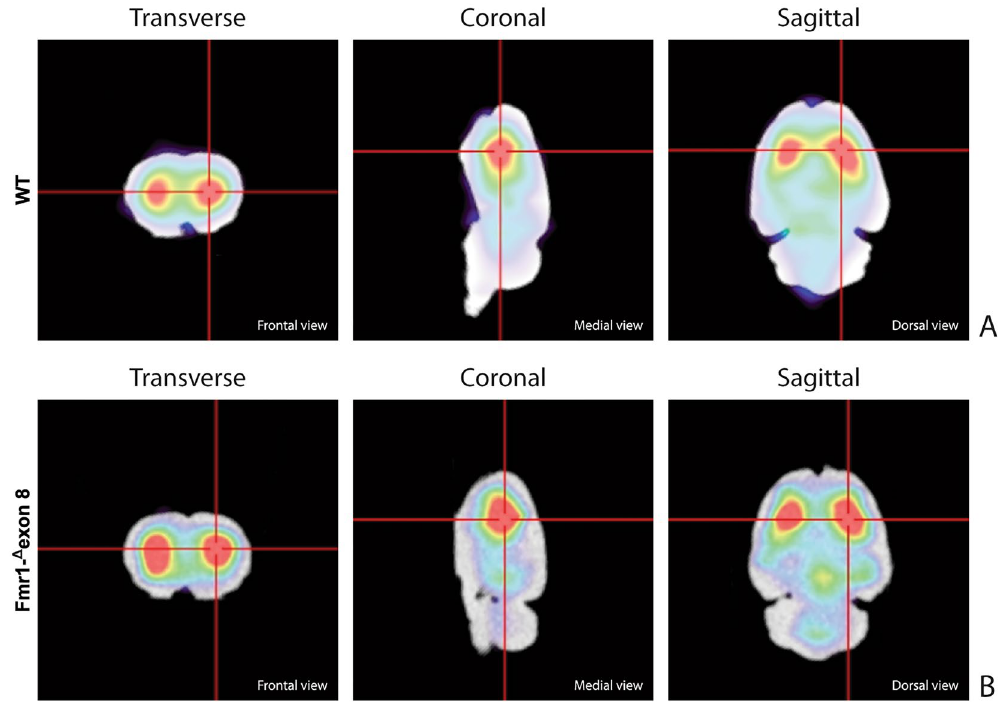
Figure 4. SPECT OSEM reconstruction of the distribution of [ 123 I]FP-CIT uptake in the rat brain. ( A ) Orthogonal views in WT adult rats. ( B ) Orthogonal views in Fmr1- Δ exon 8 adult